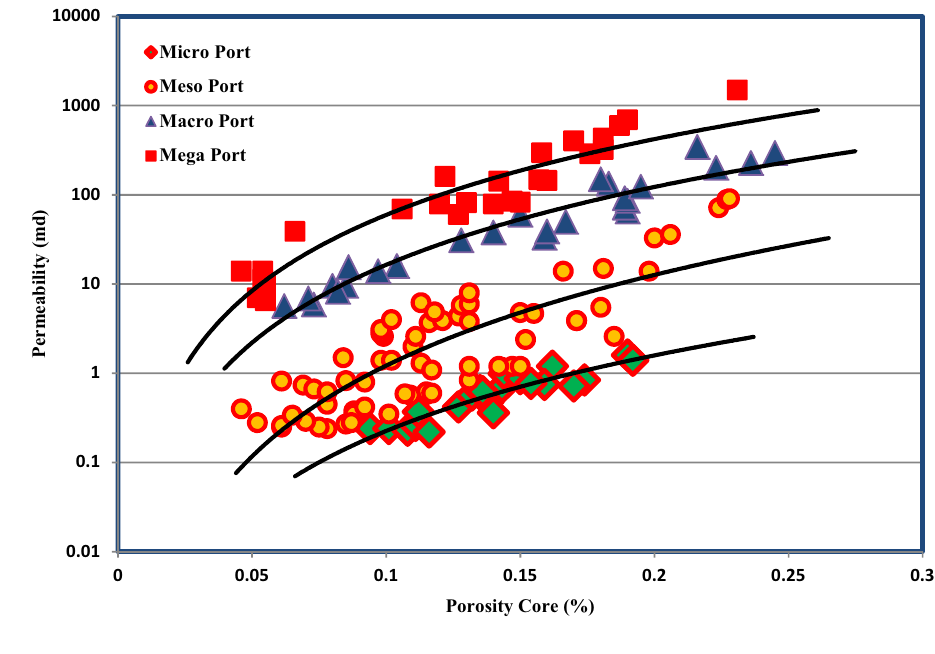
Fig. 11 Porosity–Permeability pore type